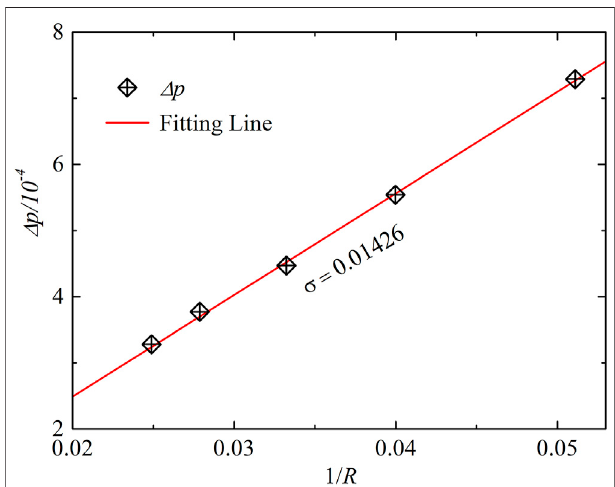
FIGURE 1 | Validation of Laplace ’ s law.